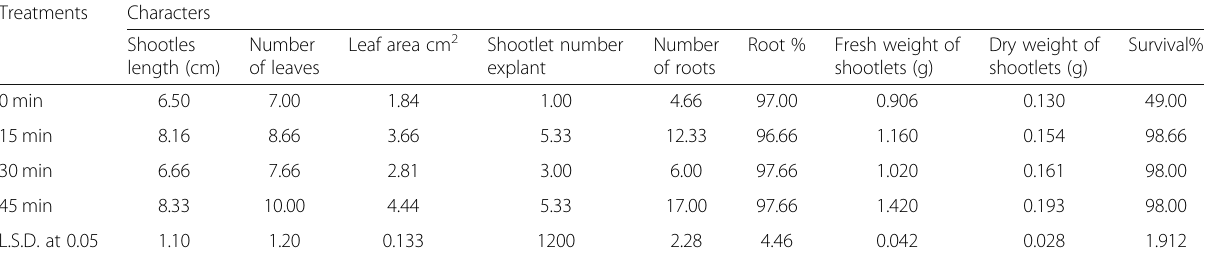
Table 2 Effect of UV-B radiation exposure time on growth parameters of Spathyiphyllum cannifolium plant in the acclimatization stage (after 2